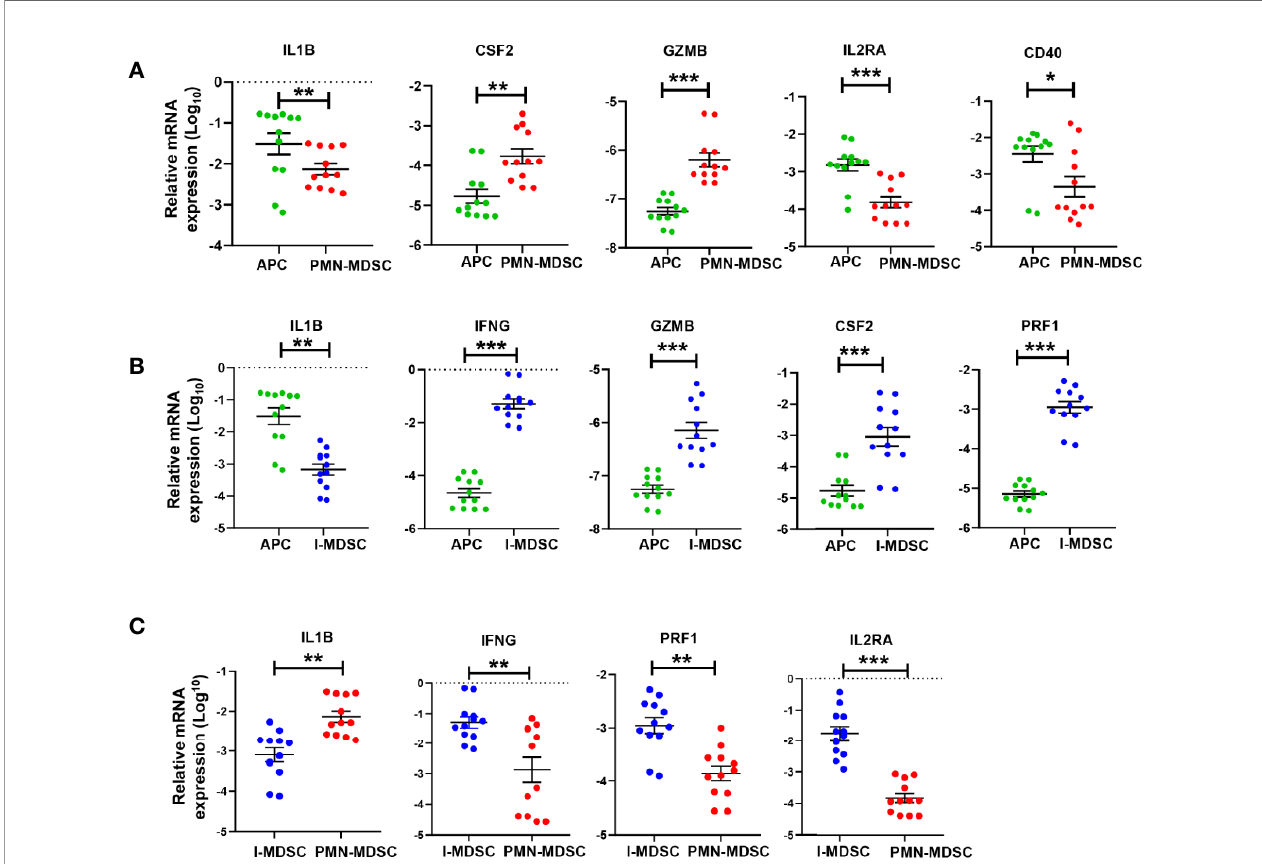
FIGURE 5 | qRT-PCR validation of selected genes in tumor-in fi ltrating APCs, PMN-MDSCs and I-MDSCs from CRC tumor tissue. mRNA expression levels for selected genes in sorted tumor-in fi ltrating myeloid cells were validated by RT-PCR; PMN-MDSC vs. APC (A) ; I-MDSC vs. APC (B) and PMN-MDSC vs. I-MDSC (C) . The relative gene expression was normalized to b -actin. Results obtained from two technical replicates of six CRC patients. The P values are indicated as follows; *** P < 0.001, ** P < 0.01, * P < 0.05. Data are presented as the mean (Log 10 ) ± standard error of the mean